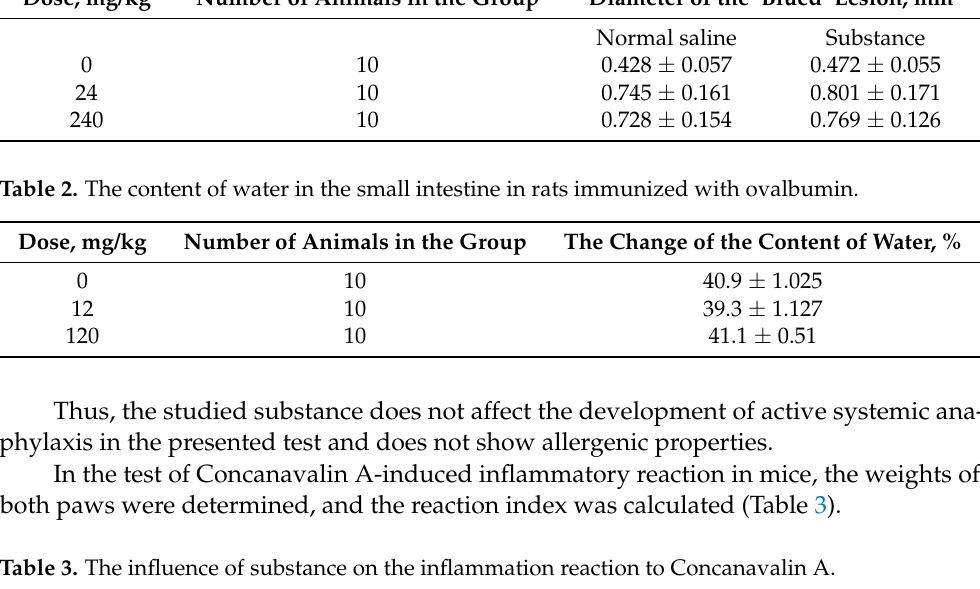
Table 1. The mean diameter of the ‘blued’ lesion surrounding the injection sites in all groups of animals. Dose, mg/kg